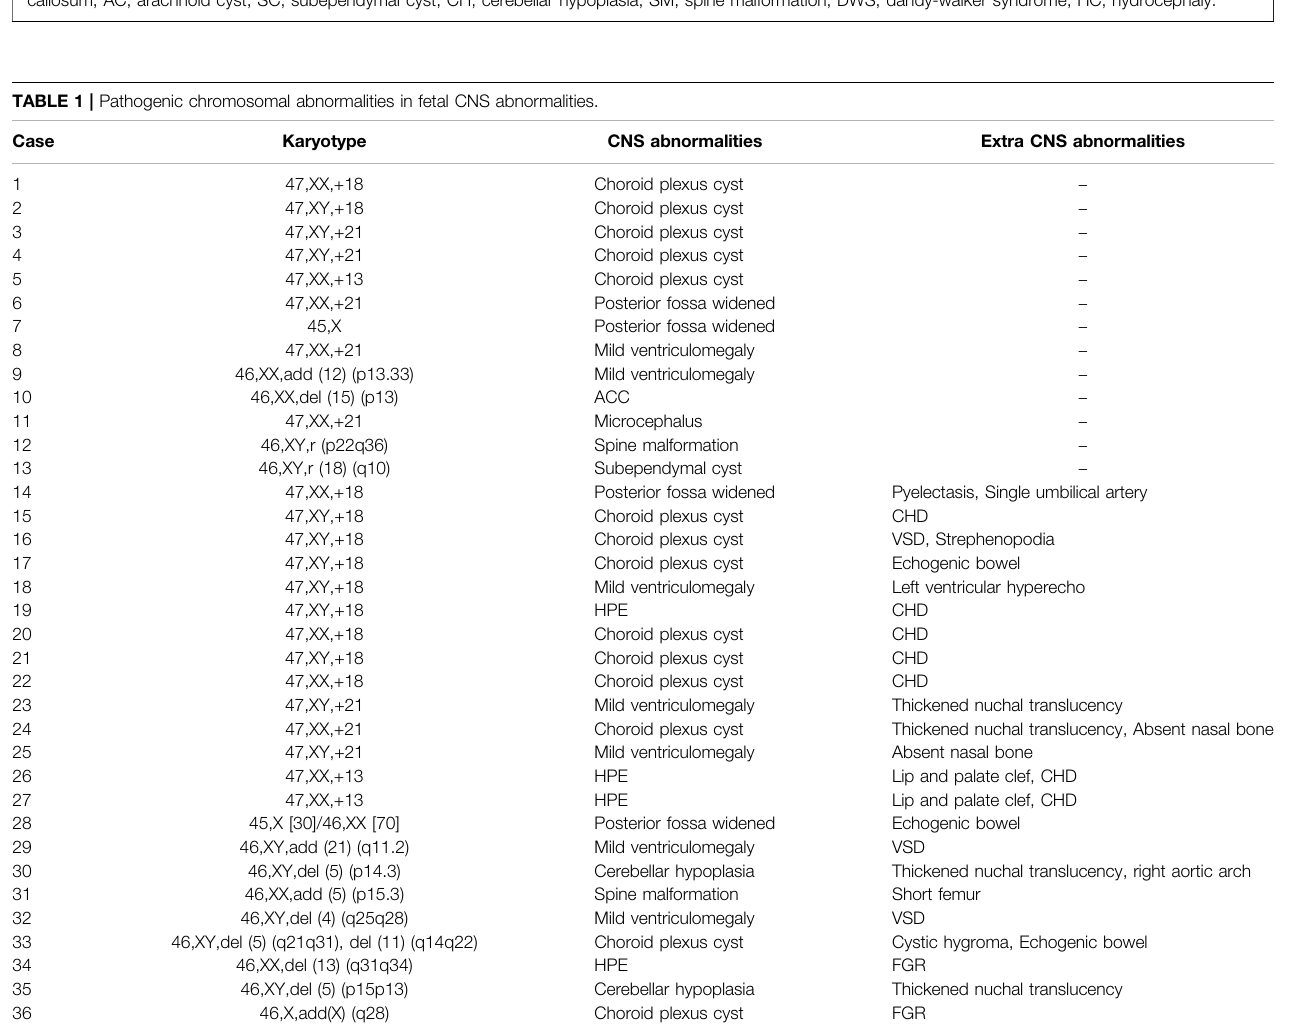
FIGURE 1 | Enrollment of Study Participants, VM, ventricular widening; CPC, choroid plexes cytsts; WPF, widened posterior fossa; ACC, agenesis of the corpus callosum; AC, arachnoid cyst; SC, subependymal cyst; CH, cerebellar hypoplasia; SM, spine malformation; DWS, dandy-walker syndrome; HC, hydrocephaly.